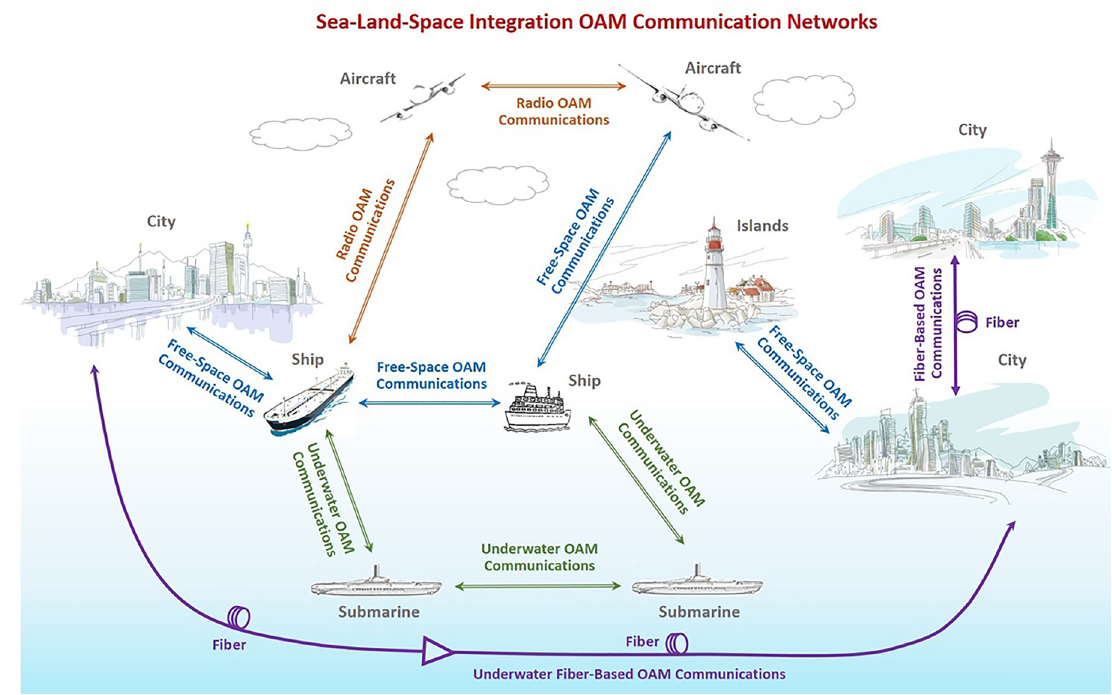
Figure 30: A vision of future OAM communication networks in multiple